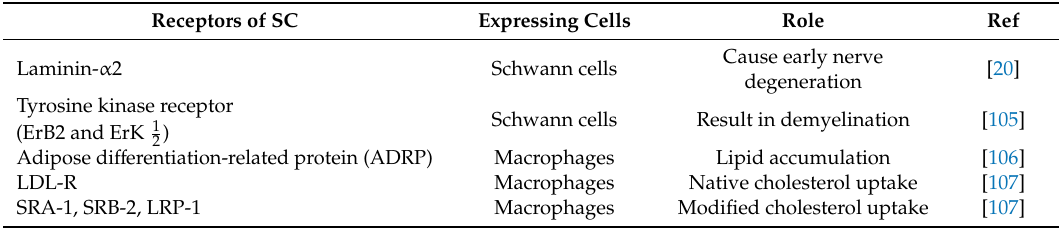
Table 3. Receptors / macromolecules that participate in M. leprae